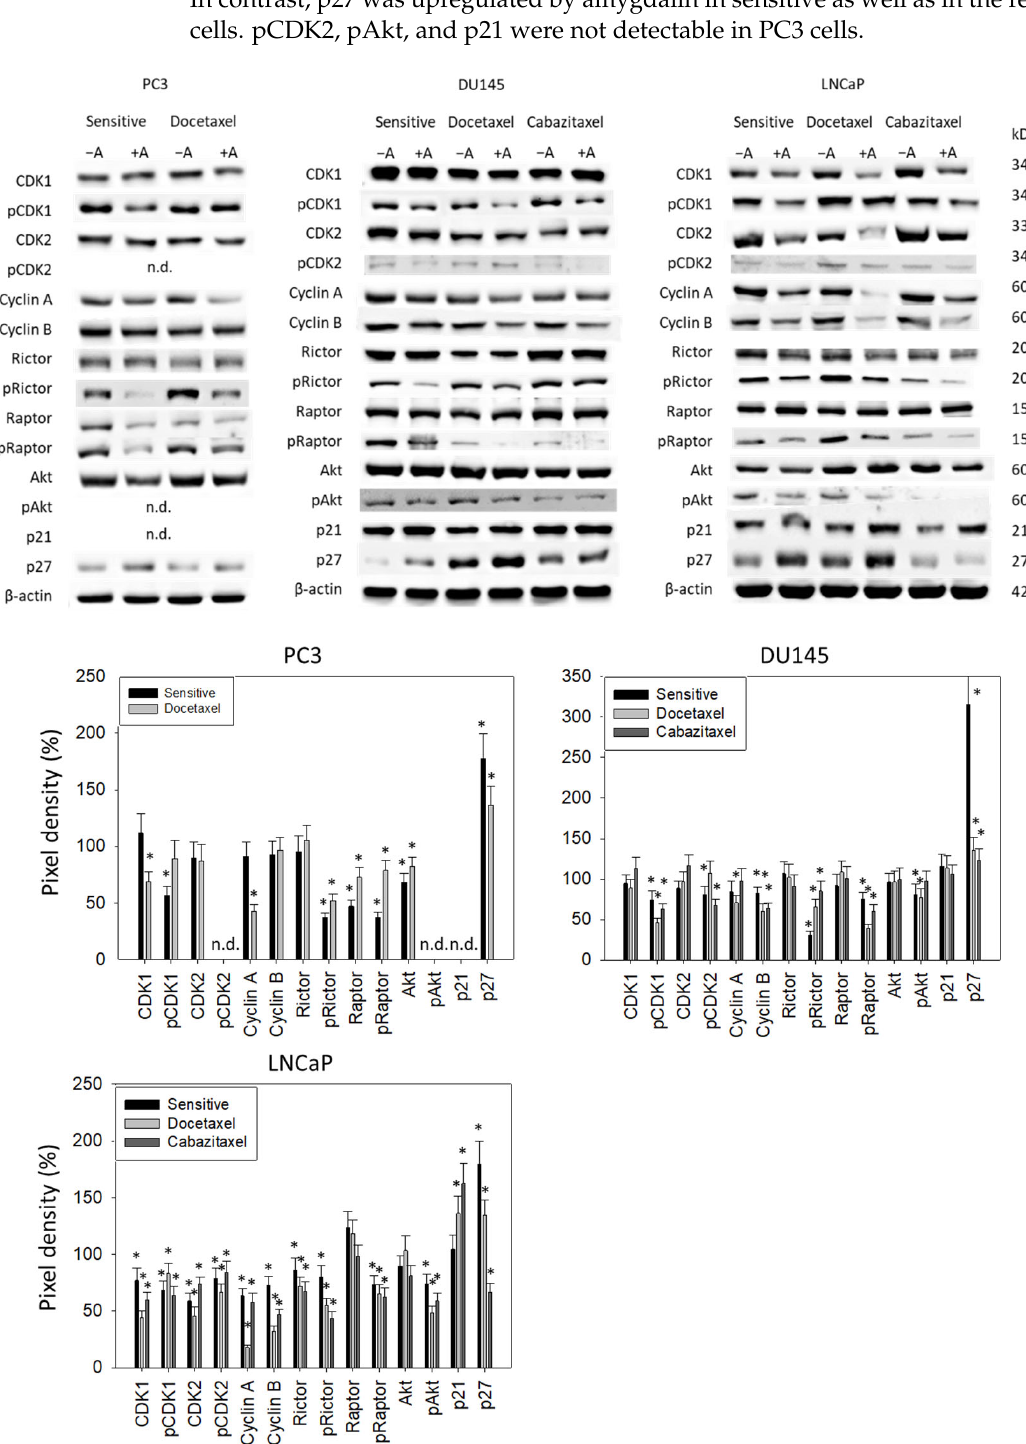
Figure 5. Up: Western blot of cell cycle and mTOR ‐ related proteins from drug ‐ sensitive and drug ‐ resistant PC3, DU145, and LNCaP cells. Tumor cells received either amygdalin (+A) or cell culture medium alone ( − A) for 24 h. β‐ actin served as the internal control. One representative from three separate experiments. n.d.: not done. Down: The ratio of protein intensity/ β‐ actin intensity expressed as a percentage of the controls, set to 100%. Error bars indicate standard deviation, n = 3. * indicates significant difference to controls. n.d.: not done. Original blots see supplementary file S1.